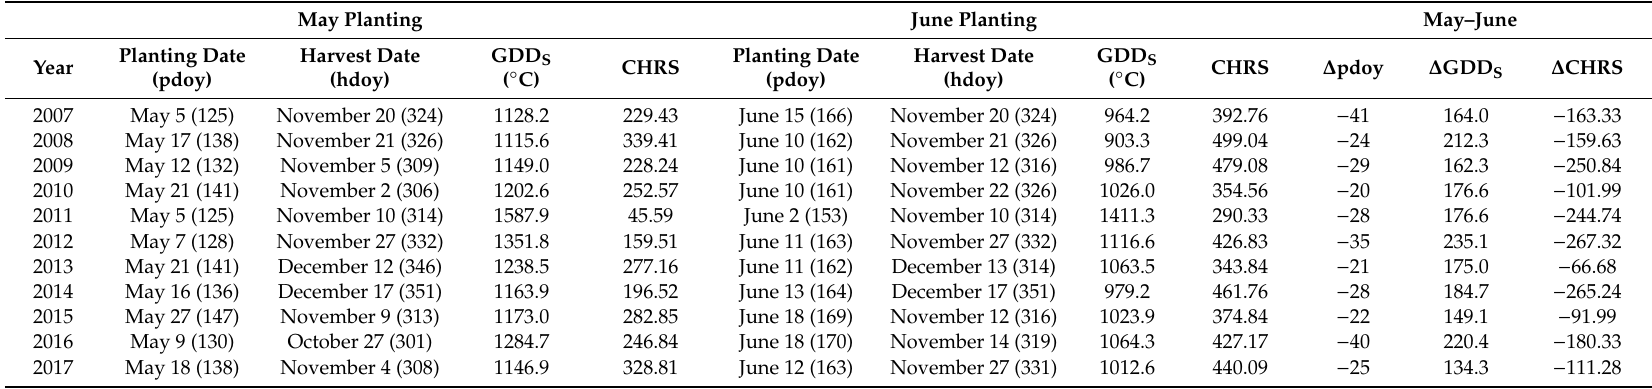
Table 1. Planting and harvest dates, total growing season growing degree days (GDD S ), and boll formation period cooling hours (CHRS) for May and June planting dates in the 2007–2017 Lubbock AgriLife variety trials. May–June ∆ values indicate June values subtracted from the same year’s May